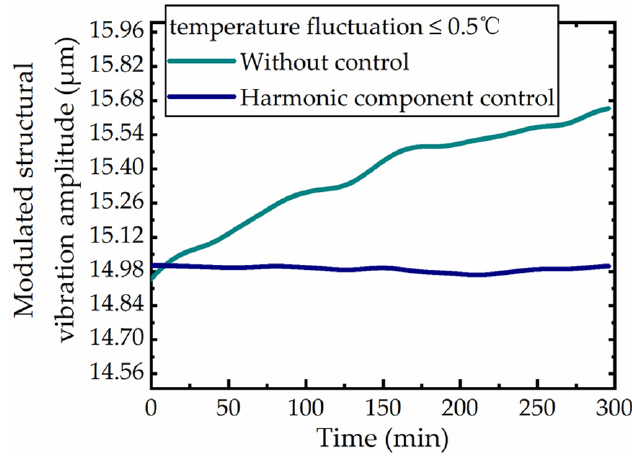
Figure 6. Control effect of the constant temperature condition.